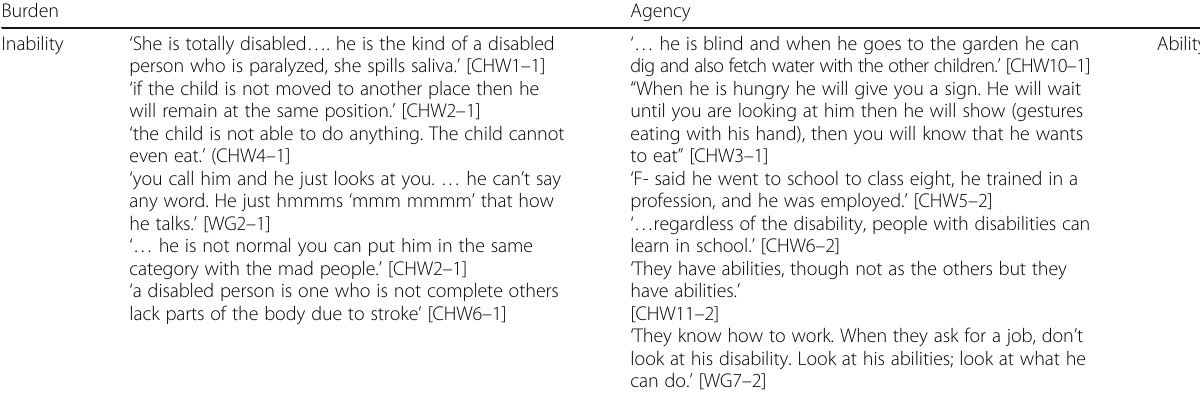
Table 2 Burden vs Agency construct: Inability-Ability Burden